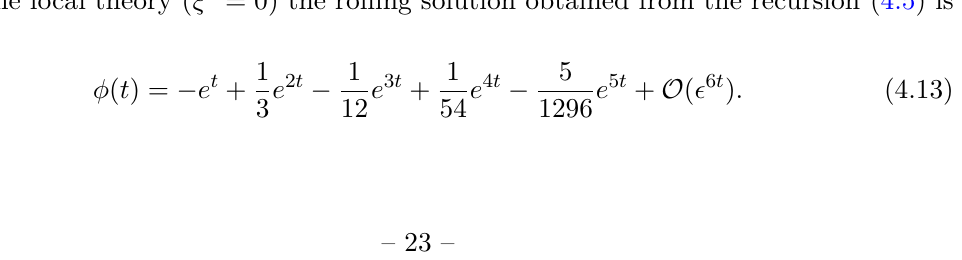
Figure 2 . The dots are log | b n | for 36 ≤ n ≤ 55 for ξ = 0 . 2 (left) and 10 ≤ n ≤ 29 for ξ = 0 . 4 (right), obtained numerically from (4.4). The curves give log | b with β = 2 . 08 (left) and β = 1 . 99 (right). The match of the logarithms is solid, giving evidence for (4.11). We found similar fits for other values of ξ using β ≈ 2